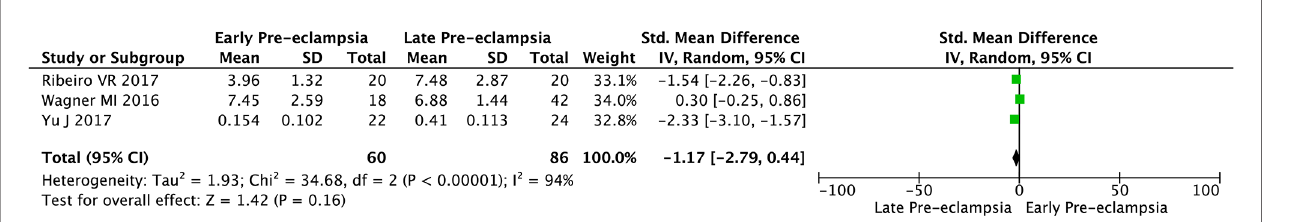
FIGURE 4 | Standardized mean difference of T regulatory cell numbers in the maternal blood of women with early and late pre-eclampsia. CI, con fi dence interval; SD, standard deviation; Std. Mean Difference, standardised mean difference; IV, inverse variance.